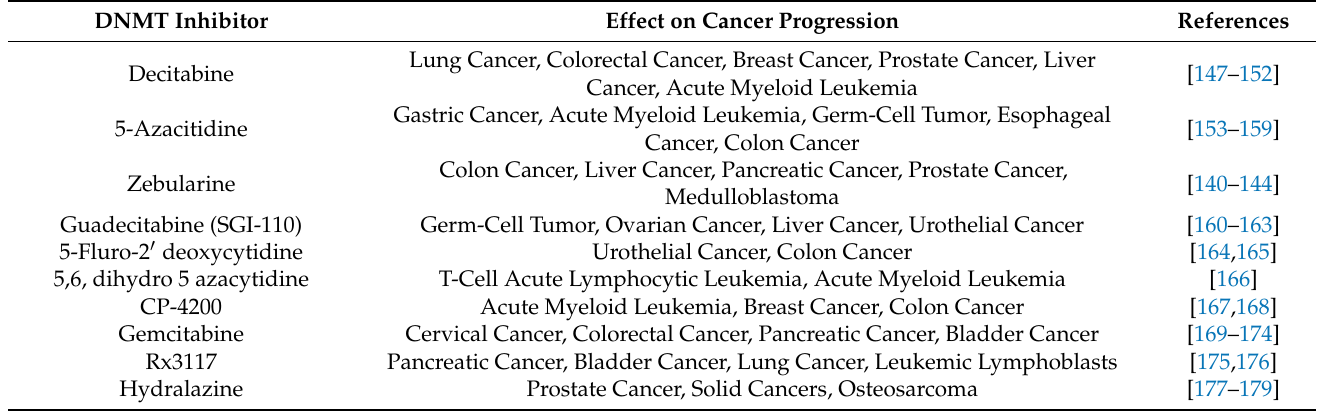
Table 1. Recent update on DNMT inhibitors relatively to the regulation of the different types of cancer